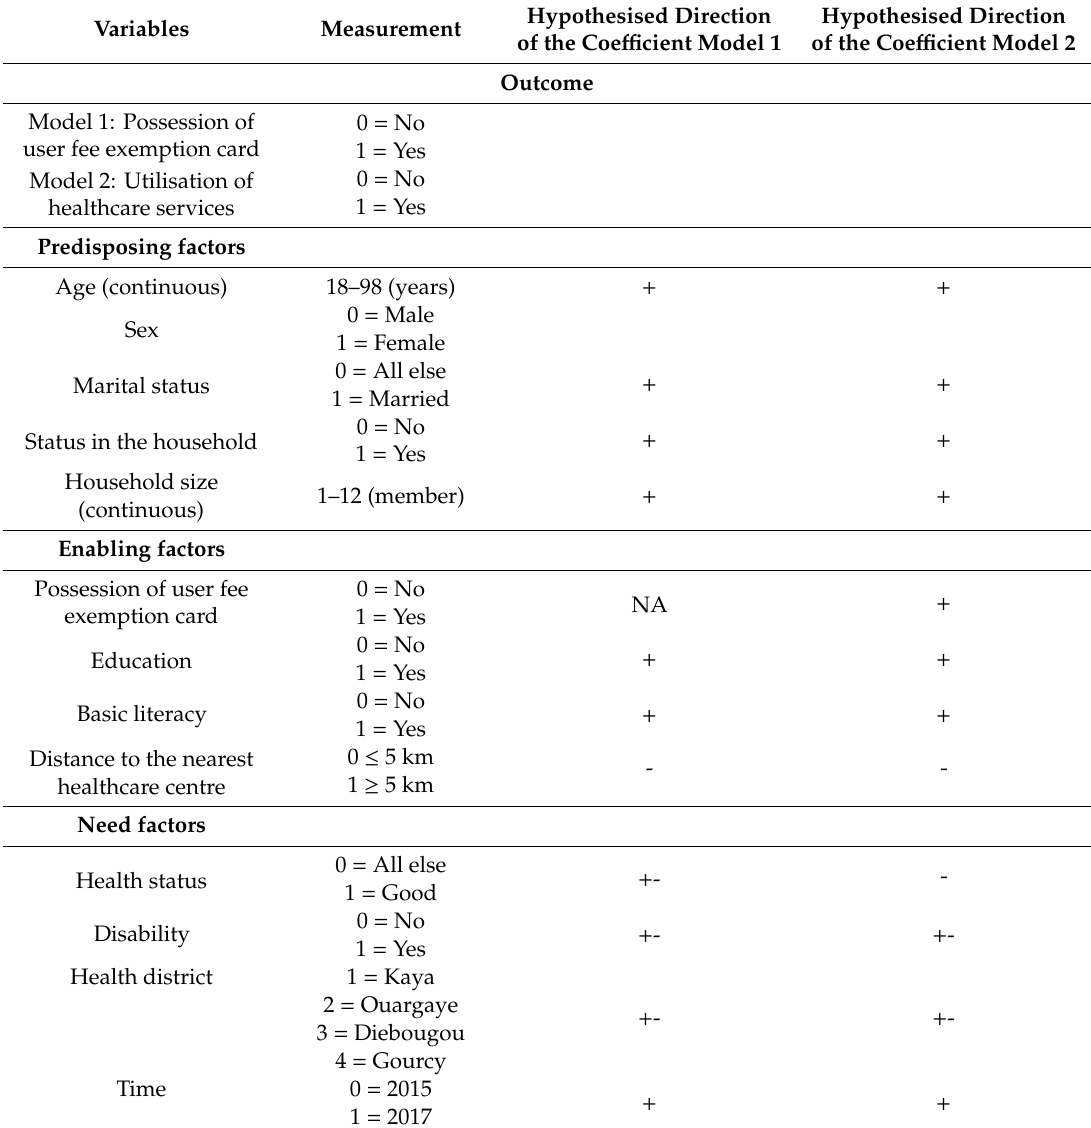
Table 2. Variables, their measurement and hypothesised direction of the coe ffi cient for Model 1 and